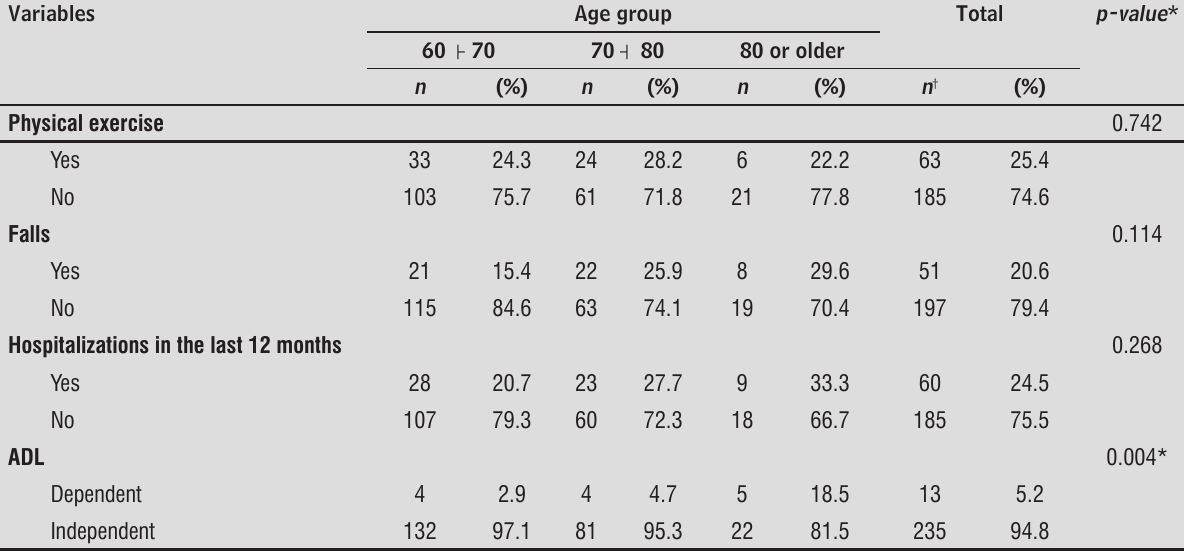
Table 2 - Distribution of clinical and health variables by age group. Uberaba, MG, Brazil, 2011 Variables